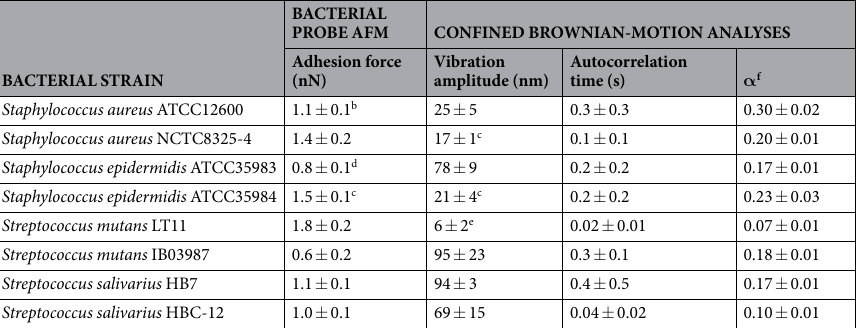
Table 1. Summary of results from analyses of confined Brownian-motion of adhering coccal bacteria and bacterial probe AFM for the different strains involved in this study a . Autocorrelation times were taken as the time after which 50% of the autocorrelation was lost, while the α values presented refer to A × t α (see also Eq. 4) for times t > 1 s. ± Signs indicate the standard errors of the mean over 10 different bacterial probes in AFM each used up to 5–10 times on different locations on a glass surface or 30–50 individual bacteria in bacterial vibration spectroscopy respectively, as divided over three separate bacterial cultures. a Motile bacterial strains and species were excluded as self-induced movement, as e.g. by flagellated strains 39 will interfere with their random Brownian-motion. b, c, d, e These data points have been published before in 15, 17, 25, 40 respectively. f α = 1 indicates free diffusion with no confinement; α = 0 indicates confinement due to permanently attached